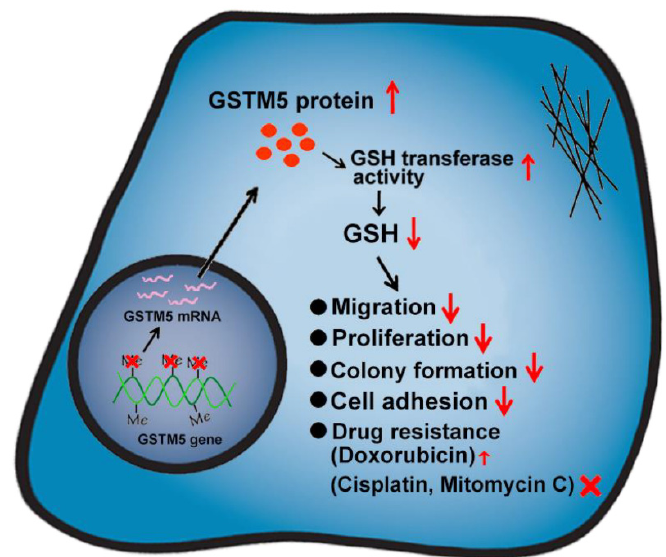
Figure 9. Schematic of GSTM5-inhibited bladder cancer. Demethylation of the GSTM5 gene CpG island promotes gene activation and mRNA expression. Increased GSTM5 protein expression reduces the intracellular GSH concentration. Decreased GSH levels inhibit cell migration, proliferation, colony formation and cell adhesion. In chemotherapeutic drug resistance, decreased GSH increases doxorubicin resistance slightly but has no effect on cisplatin and mitomycin C. Supplementary Materials: The following are available online at https://www.mdpi.com/1422-0067/22/6/3056/s1, Video S1: Wound healing assay. Time-lapse images were recorded from 0 to 14 h after wound production. The real time is presented in the right-upper corner. Left: 5637 cells, middle: 5637VC cells, right: 5637ovGSTM5